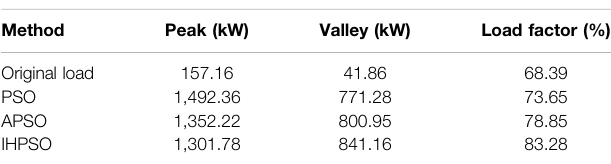
TABLE 2 | Load optimized value.